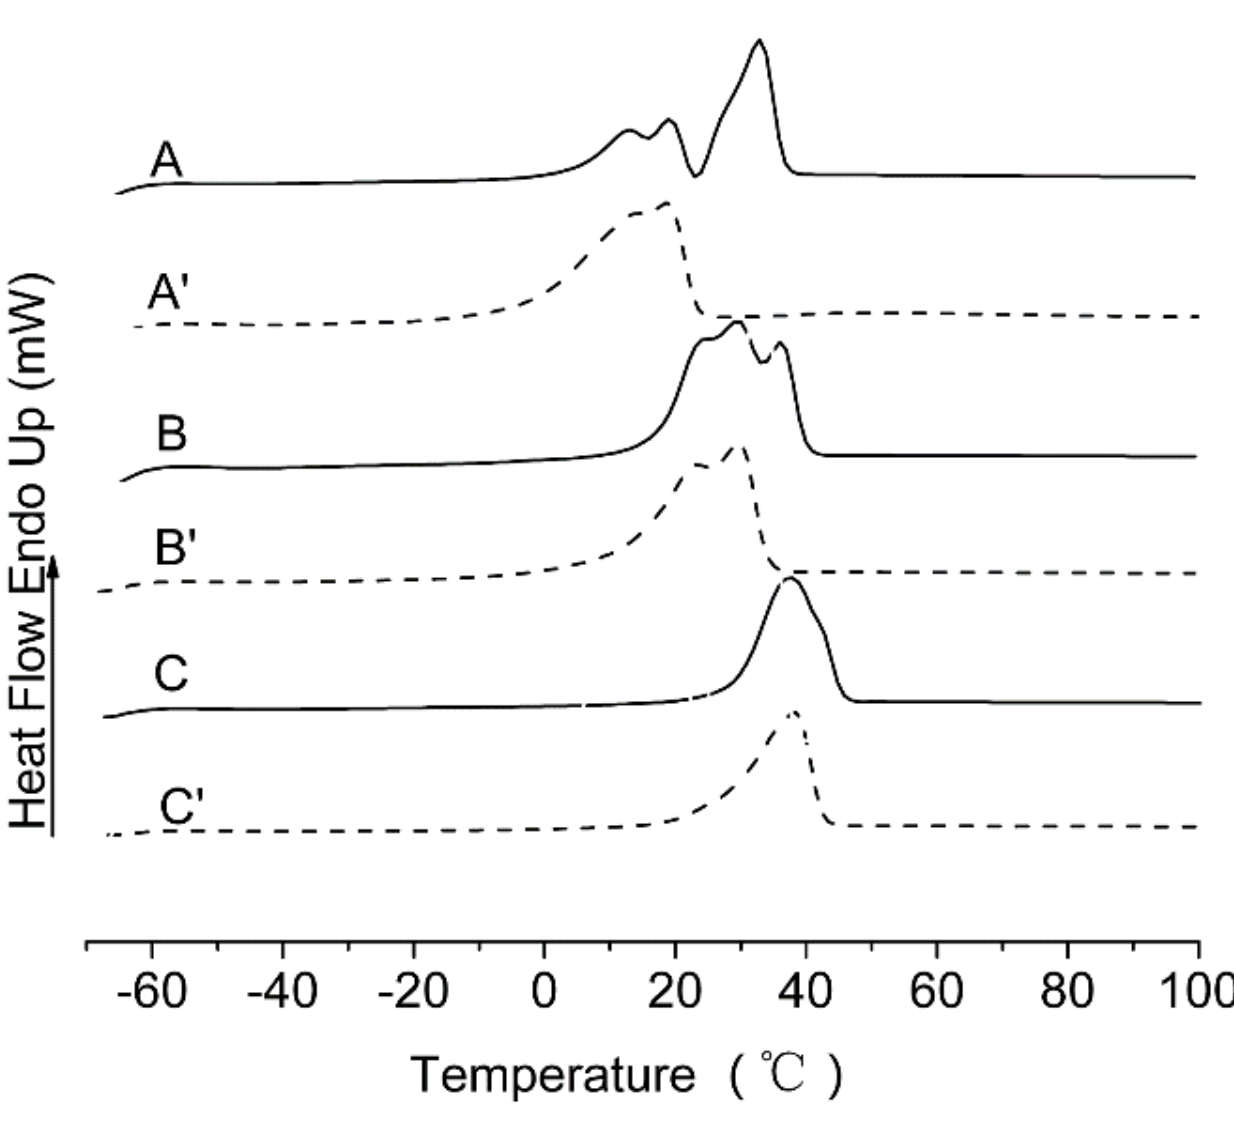
Figure 3. DSC curves of (A) m PEG-HTO- m PEG −1; (A’) m PEG550; (B) m PEG-HTO- m PEG −2; (B’) m PEG750; (C) m PEG-HTO- m PEG −3; (C’) m PEG1000; Heating rate 10 °C/min.